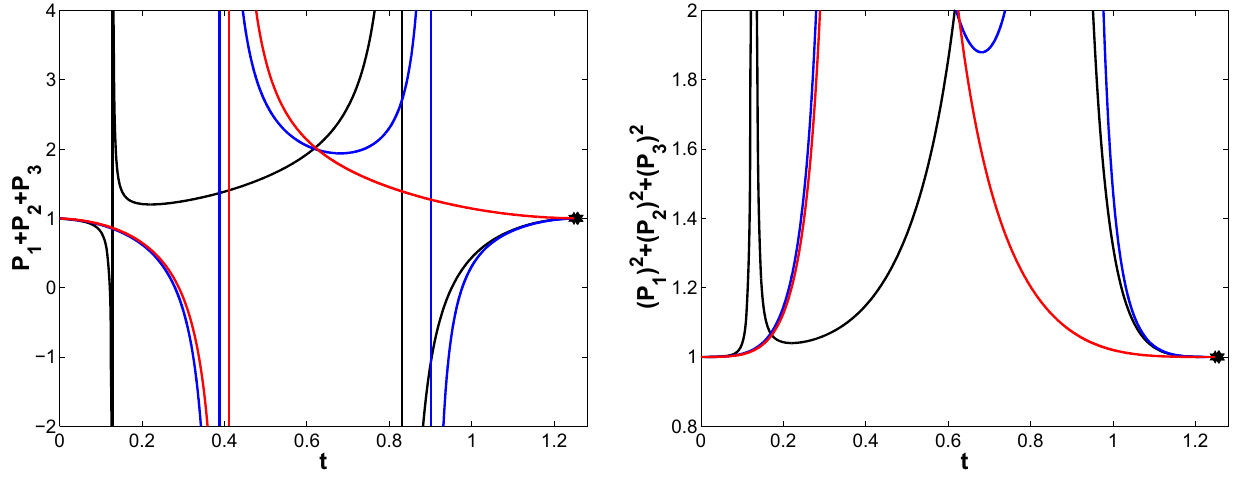
. Initial values of H a ( 0 ) , H b ( 0 ) are 12